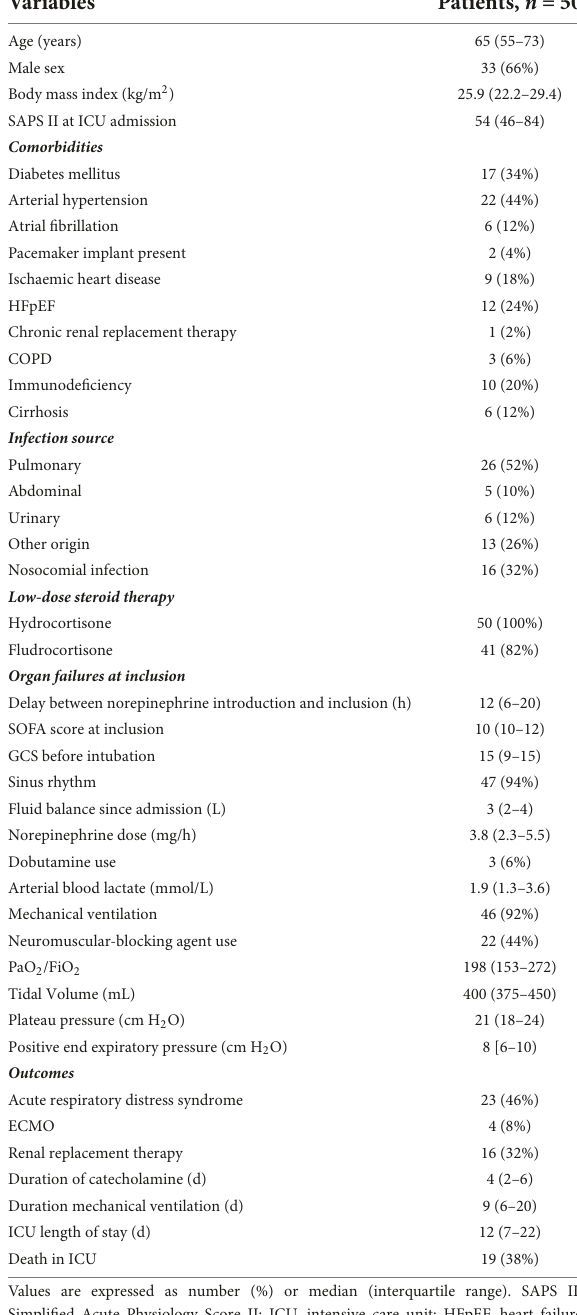
TABLE 1 Clinical characteristics of study patients and organ